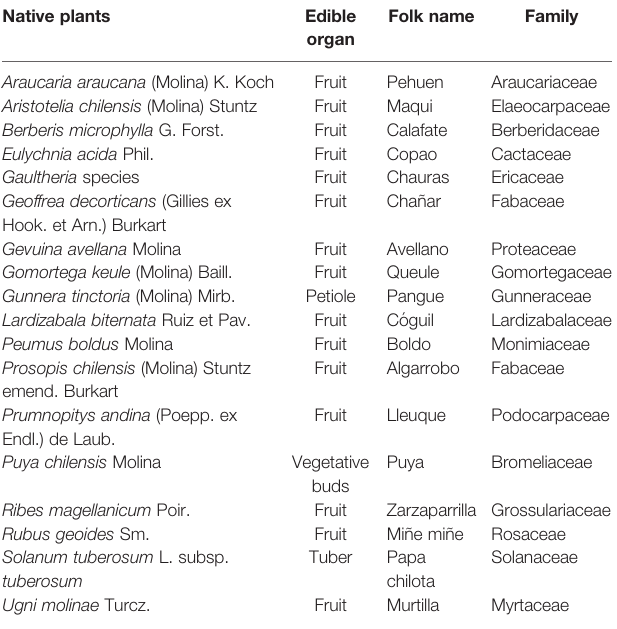
TABLE 1 | Native plants from the Chilean winter rainfall-Valdivian forest hotspot with potential in agriculture. Native